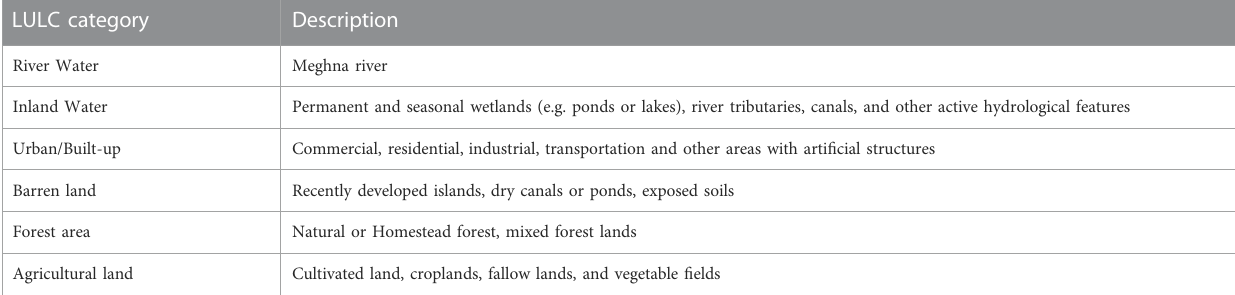
TABLE 1 Description of the LULC categories used for the classi fi cation. LULC